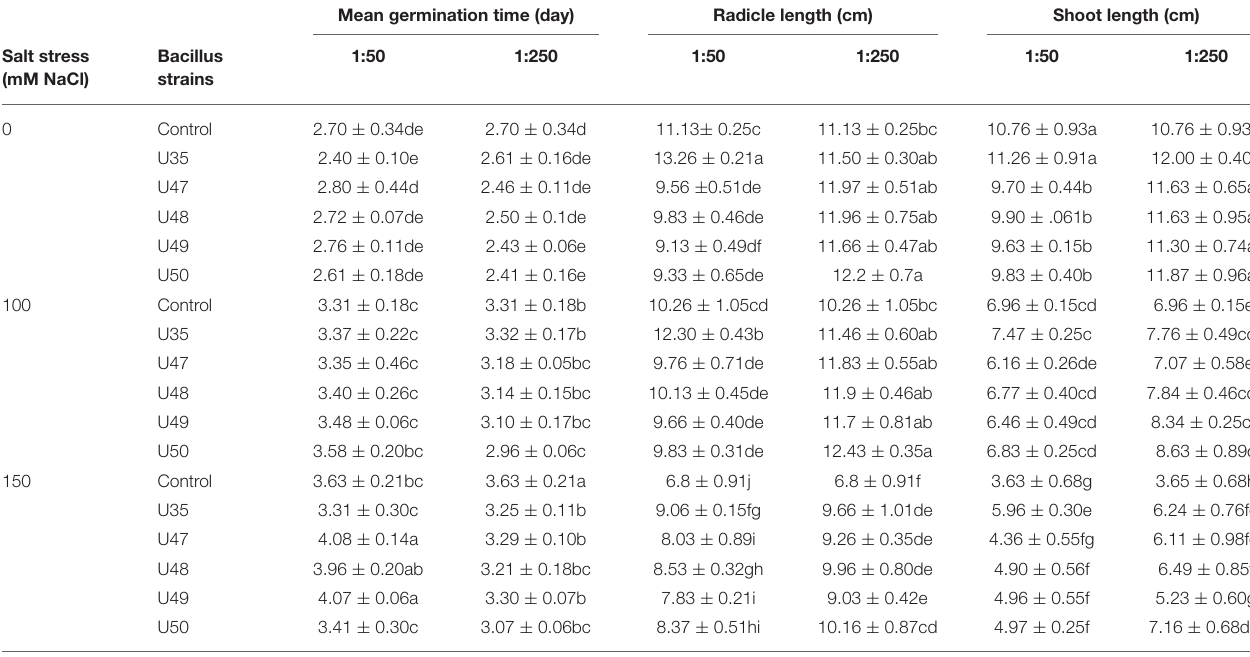
TABLE 1 | Effect of Bacillus strain CFS dilution (1:50 and 1:250) and salinity on seed quality variables of corn. Mean germination time (day) Radicle length (cm) Shoot length (cm)